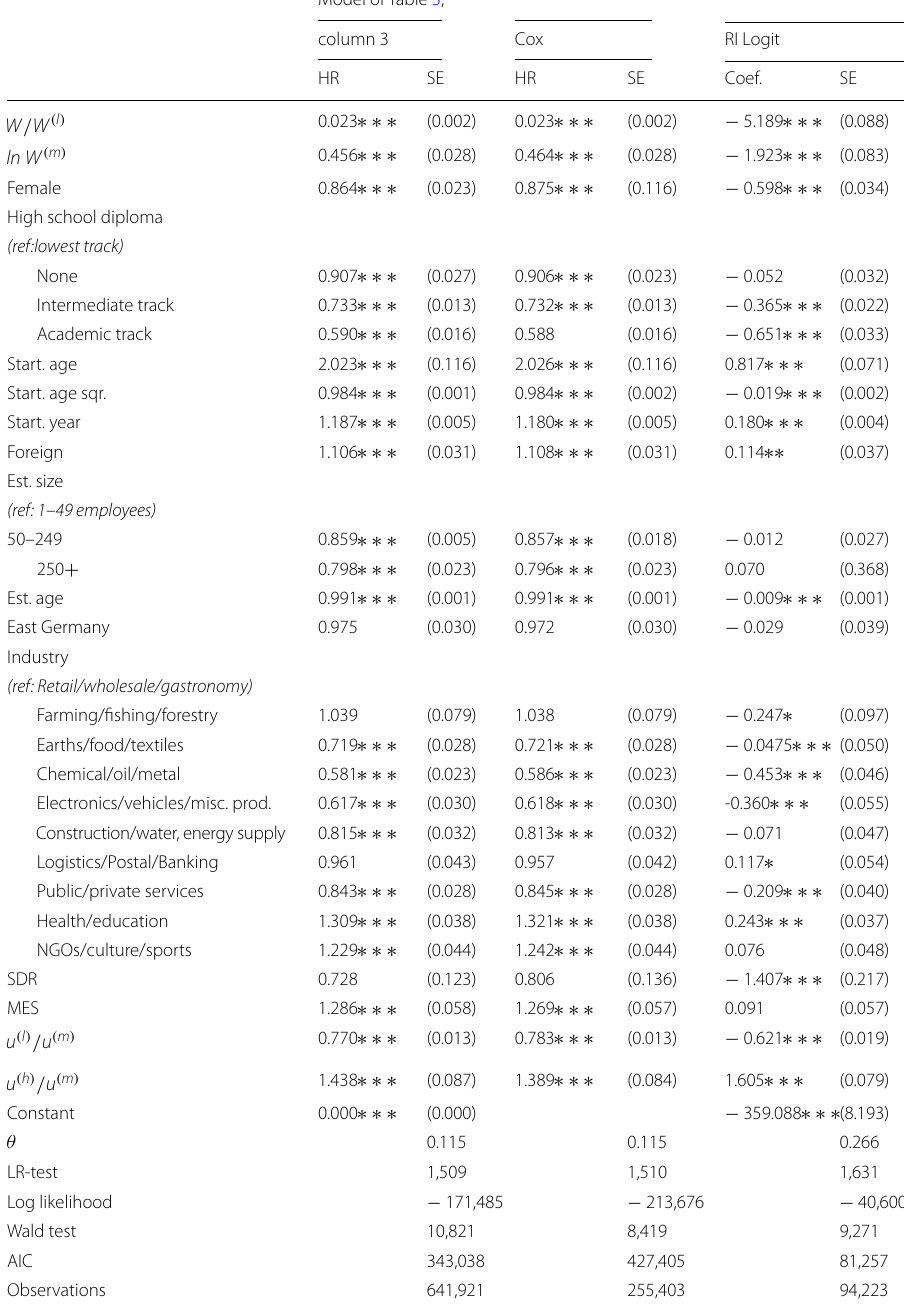
Table 6 Estimation results for the Cox model and RI Logit model